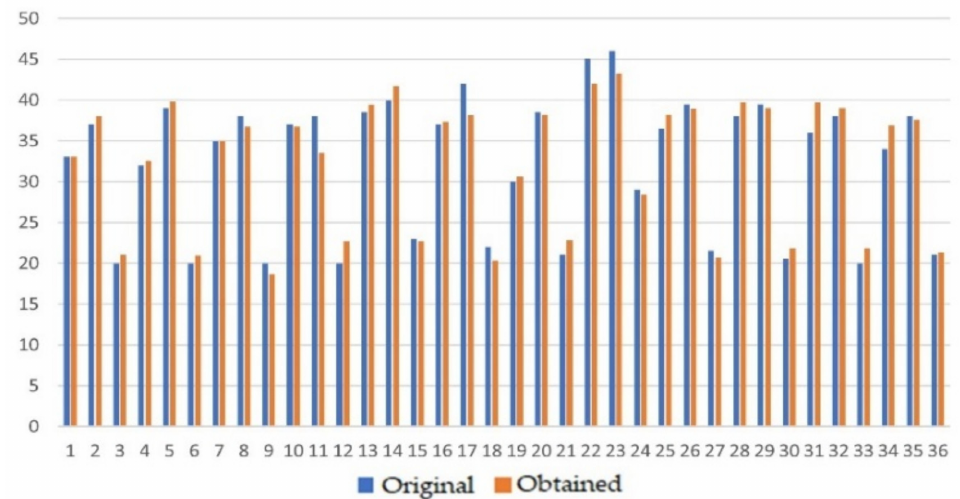
Figure 13. Bar chart of the original and obtained